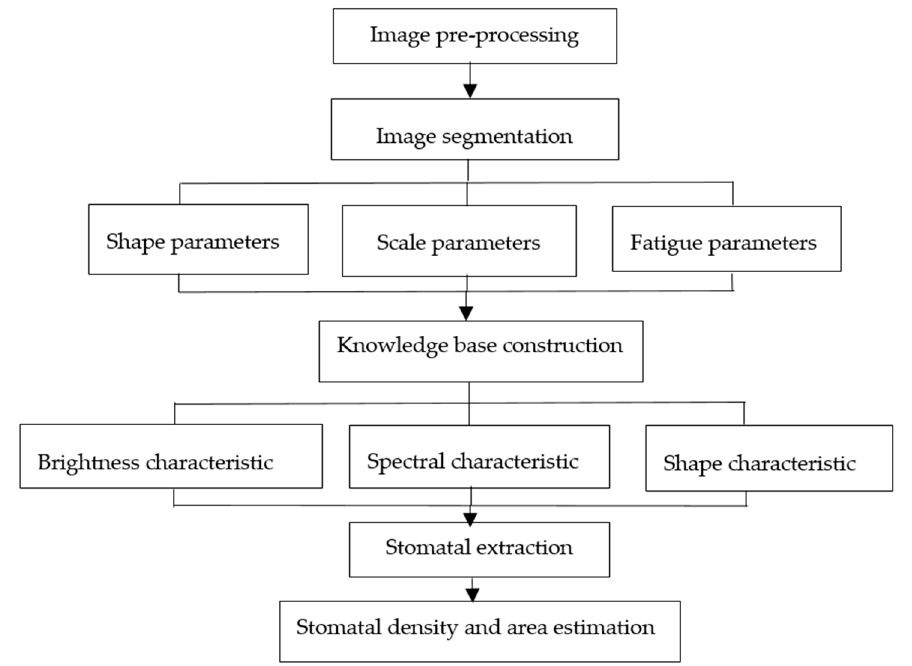
Figure 1. Flow chart of stomatal extraction on the basis of eCognition.